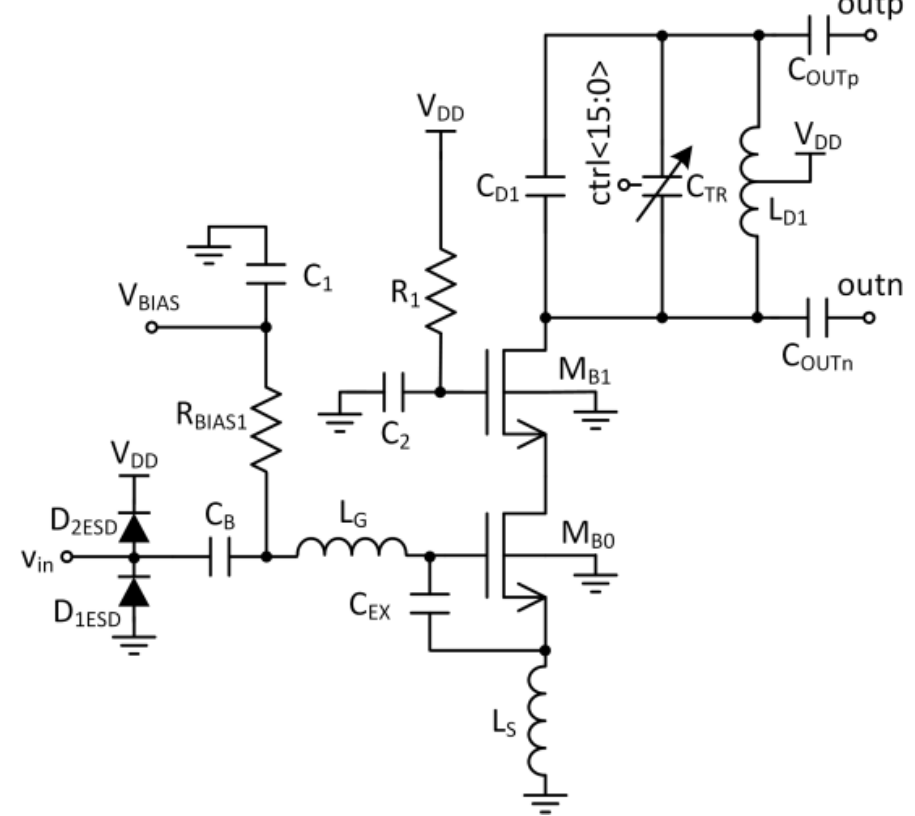
Figure 3. Schematic diagram of the proposed active balun and ESD protection.